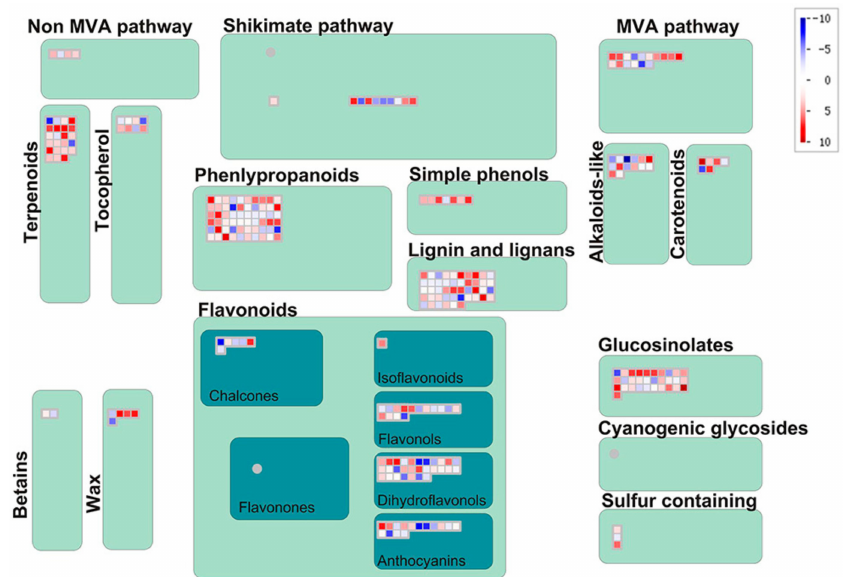
Figure 4. The expression profiles for secondary metabolic-related DEGs analyzed by MapMan. The color bar indicates the normalized log 2 transformed fold change value in hexaploid compared with diploid, red indicates up-regulation and blue indicates